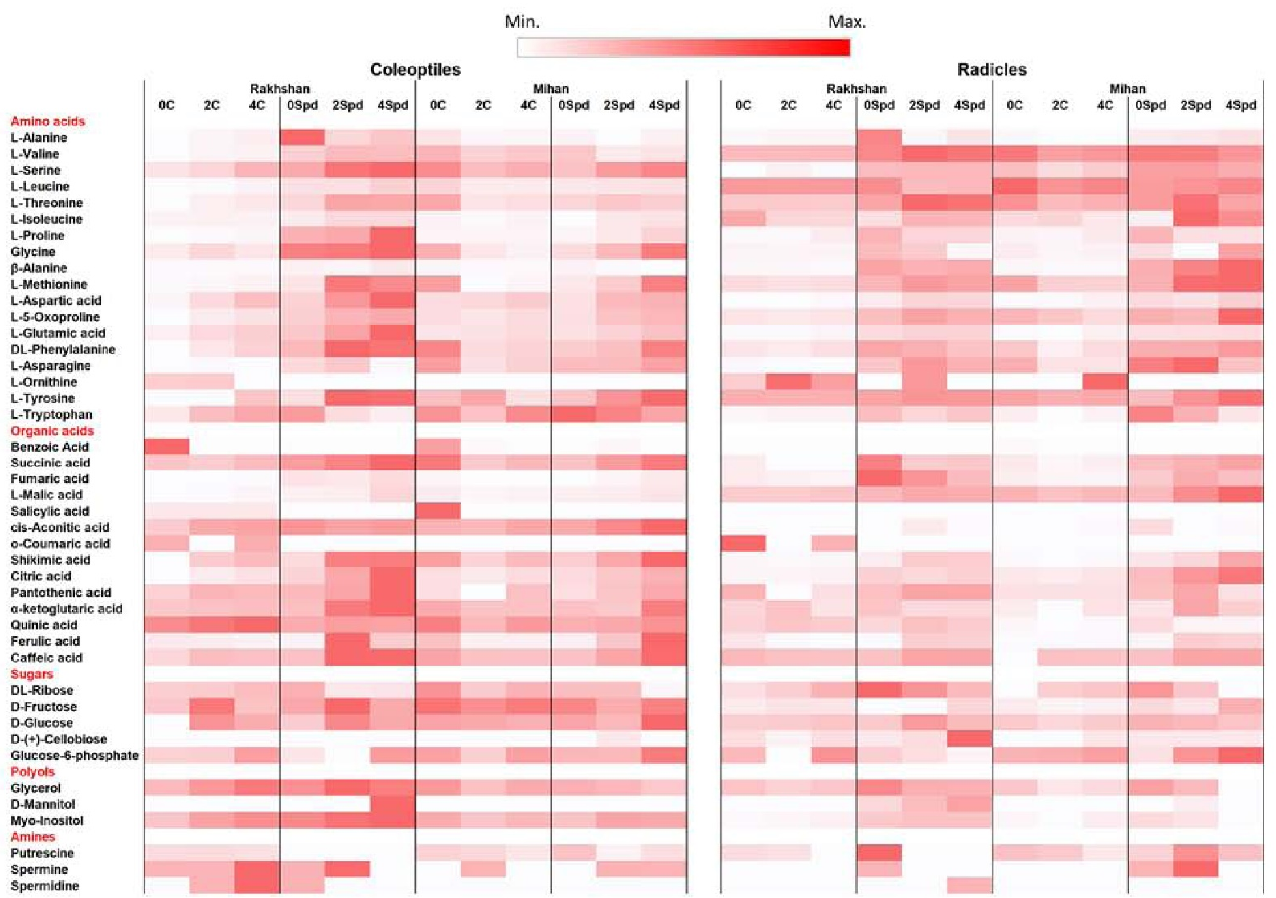
Figure 10. Number of the differentially expressed metabolites in two varieties (Mihan and Rakshan) under PEG 6000 treatments. 0, 2, and 4 indicates control, −2 MPa, and −4 MPa PEG treatments, re- spectively. Up: statistically significant increased, down: statistically significant decreased levels.